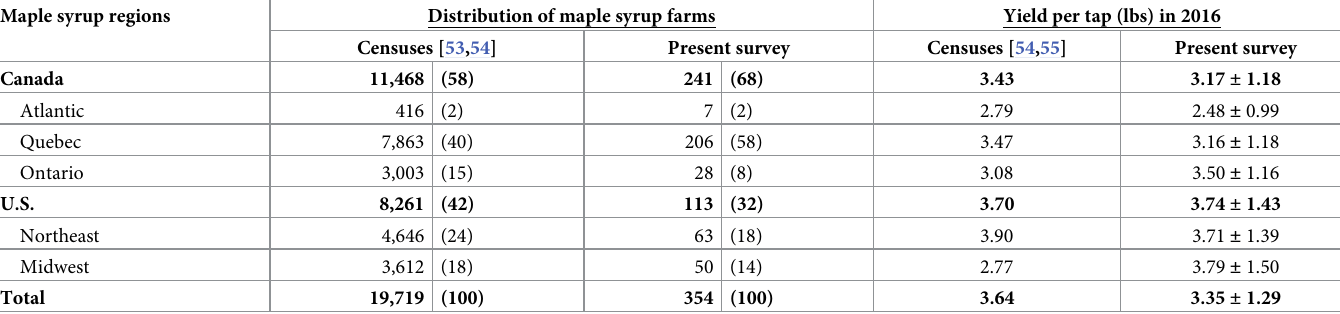
Table 1. Comparisons between the distribution of maple syrup farms in North America (regions correspond to Fig 1) and the mean yield per tap per region with the results of our survey. Maple syrup regions